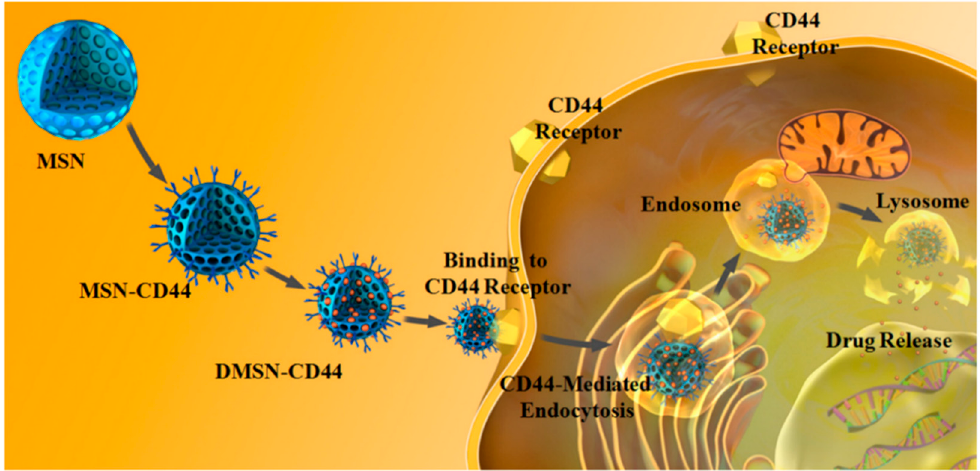
Figure 2. Schematic illustration of an MSN-based protein (CD44 McAb) and chemotherapy drug targeted co-delivery system and overcome multidrug resistance in MCF-7/MDR1 breast cancer cells [83] .